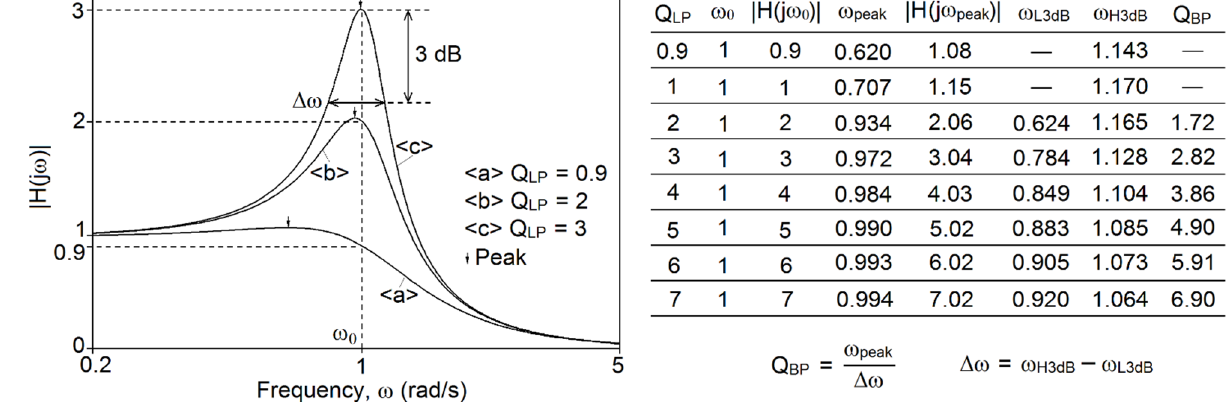
Figure 1. A family of plots of the amplitude characteristics for different Q LP ( A = 1) and detailed numerical data on the plot parameters.